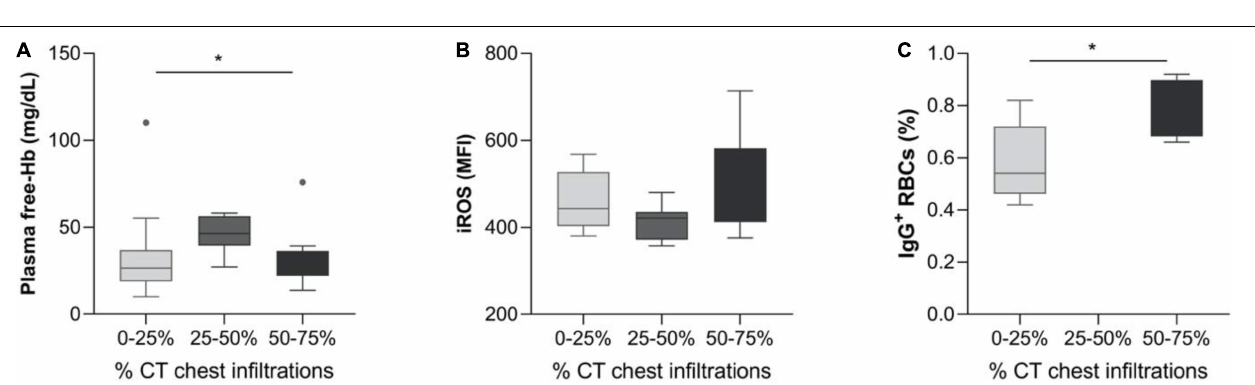
FIGURE 2 | Hemolysis and erythrocyte characteristics in SARS-CoV-2 patients, grouped by chest CT infiltrates. Box and whisker plot [using the Tukey method] illustrating: (A) Plasma free-Hb, (B) iROS, and (C) IgG + RBCs. * p < 0.05, ** p < 0.01.